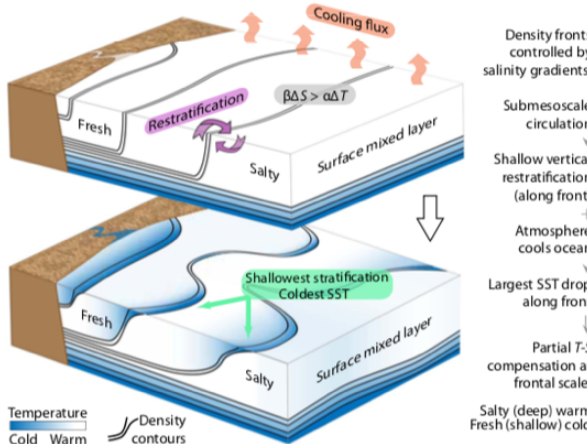
Figure 22. Interaction of sub-mesoscale salinity gradients with at- mospheric cooling leads to shallow cold regions (from Jaeger and Mahadevan,